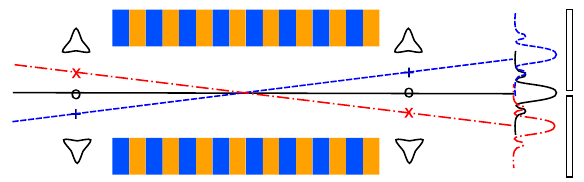
scale.FIG. 4. Schematic of vertical electron beam orbit bumps through an insertion device, at a single photon energy corre- sponding to an odd undulator harmonic. From an initial orbit through vertical positions denoted by ∘ , orbit correctors change the electron beam trajectory angle υ measured at beam position monitors to × and þ . This varies the angle of insertion device radiation measured passing the fixed pinhole